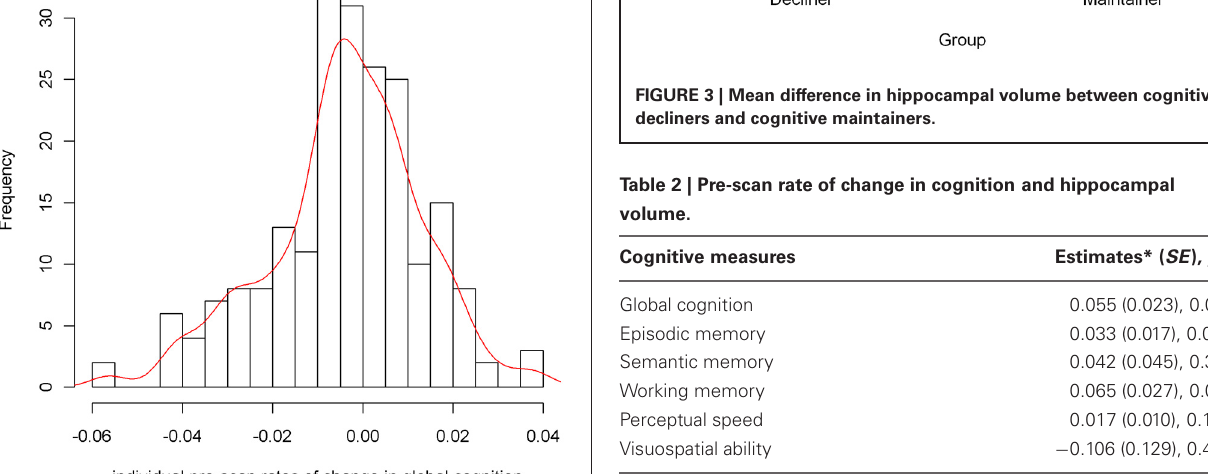
* Estimates refer to the increase in hippocampal volume ( × 10 − 3 ) with every 0.01 unit increase in rate of change in cognition. All the models were adjusted for age at scan, sex, and years of